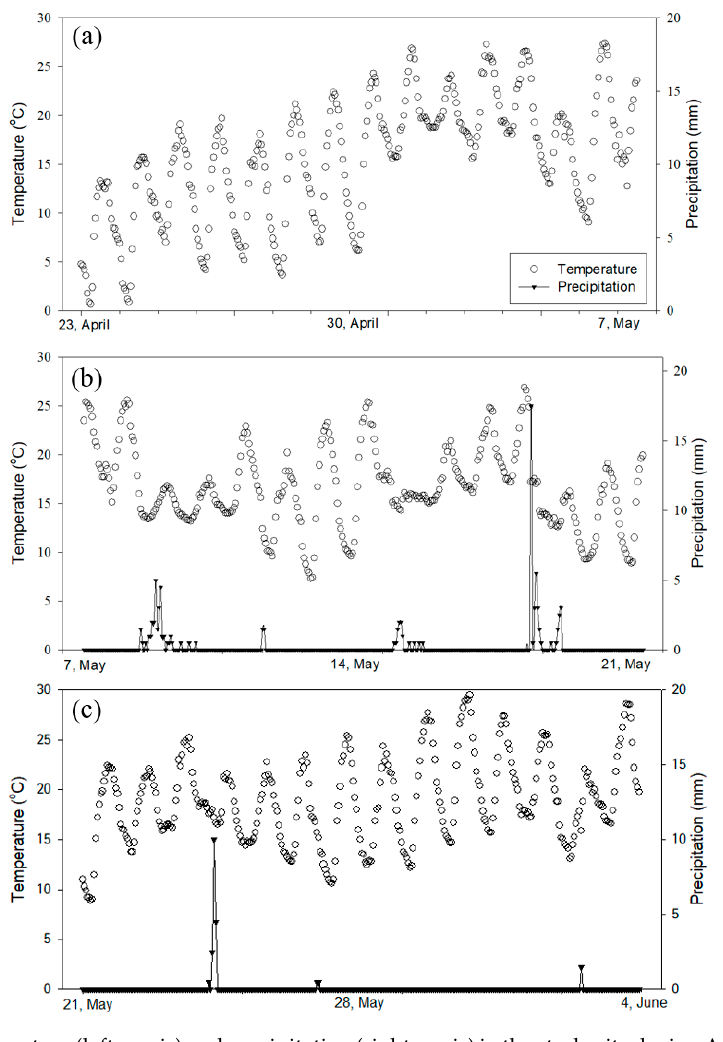
Figure 2. Temperature (left y-axis) and precipitation (right y axis) in the study site during April 23–June 4. ( a ) After tillage (April 23–May 7); ( b ) After chemical fertilizer application and irrigation (May 7–May 21); ( c ) After transplanting rice seedlings (May 21–June 4).